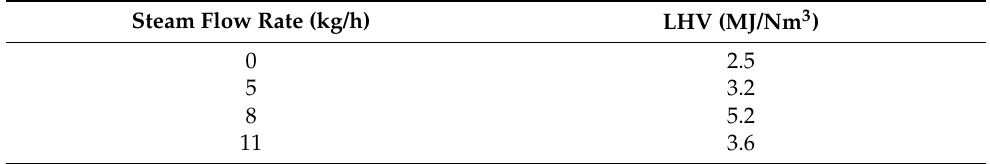
Table 5. Lower heating values of